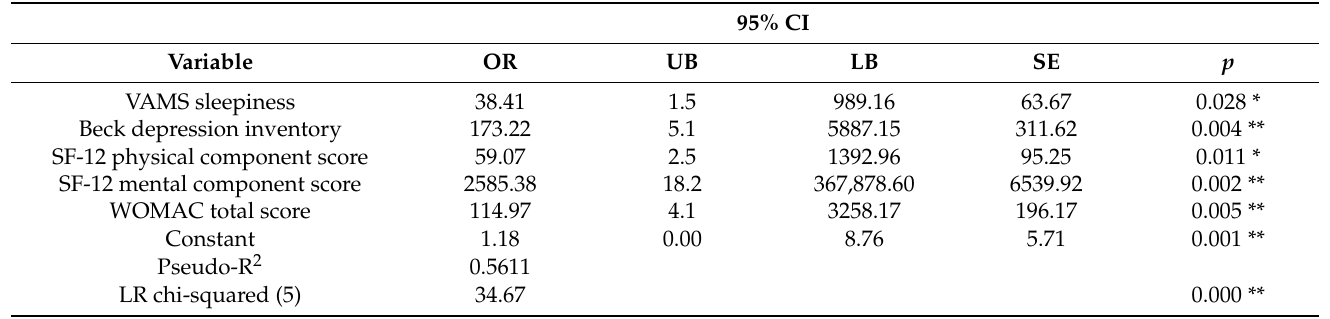
Table A1. After application of the backward elimination approach to construct the final Table 2. Final predictive multivariate logistic model.